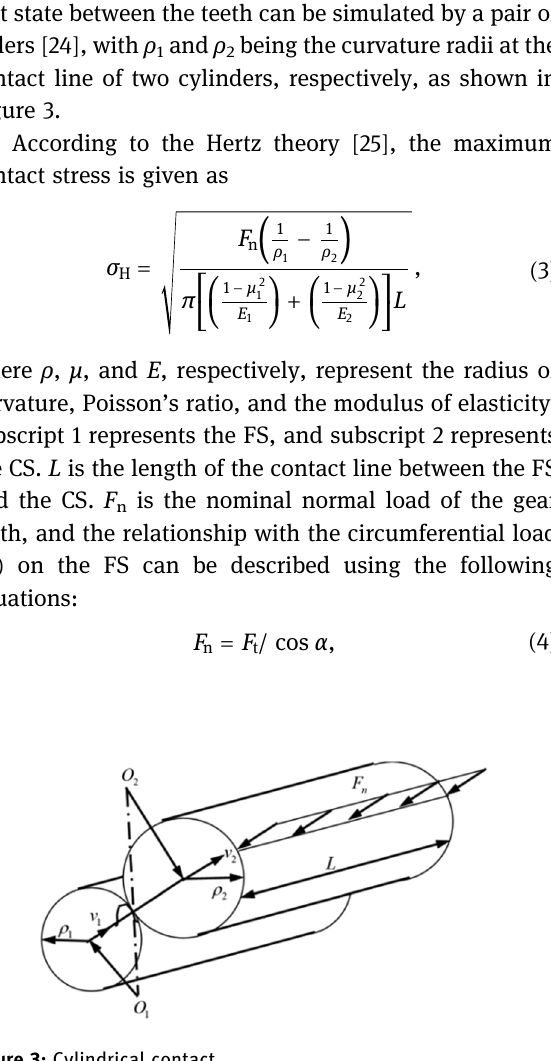
Figure 2: A simpli fi ed contact model. Figure 3: Cylindrical